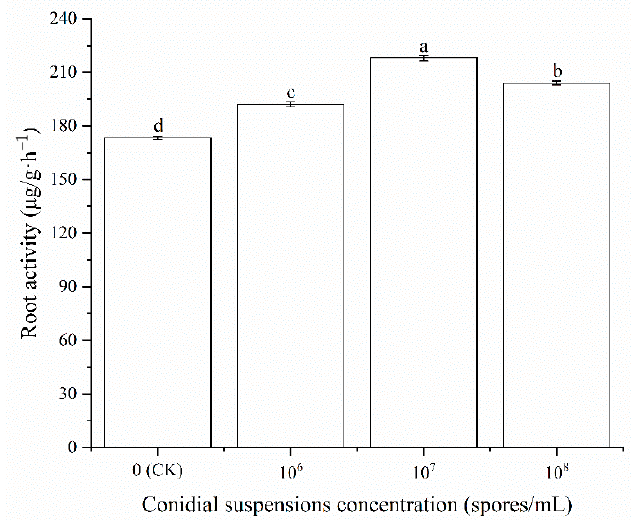
Figure 3. Effects of different concentration conidial suspensions of HT-1 strain on the root activity of R. palmatum. Values are mean ± SD ( n = 15 plants). Different letters above the bars indicate the differences are significant at p < 0.05.